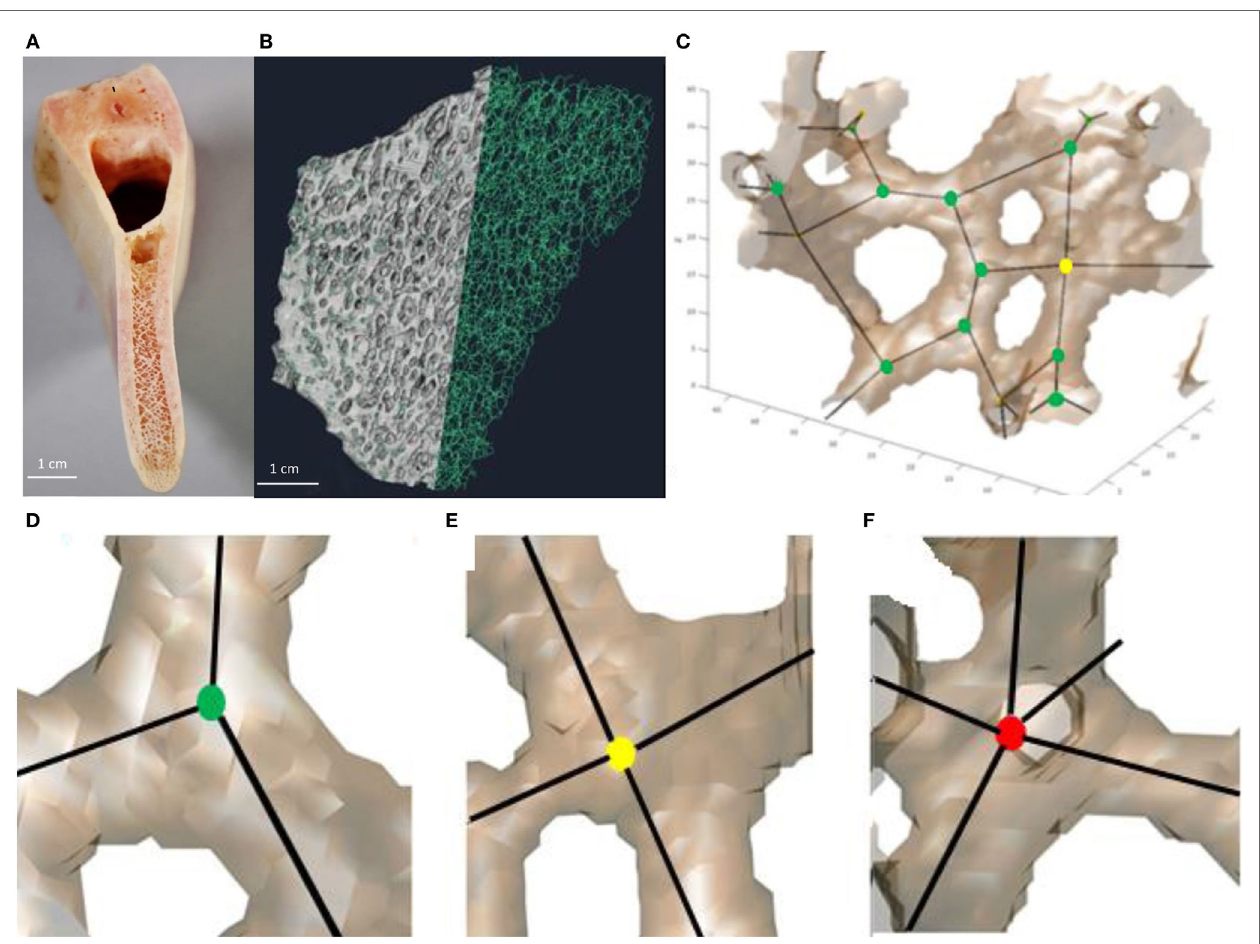
FigUre 2 | Workflow of bone analysis using inter-trabecular angle application. (a) Fragment of the pig mandible that shows the trabecular interior of the mandible body. (B) Smaller fragment of trabecular bone in which trabeculae on the left-hand side were replaced by thin lines (edges, referred to as skeletonization). (c) Group of connected trabeculae with straight edges and nodes inscribed. (D–F) Examples of nodes with different connectedness: (D) 3-N node, (e) 4-N node, and (F) 5-N